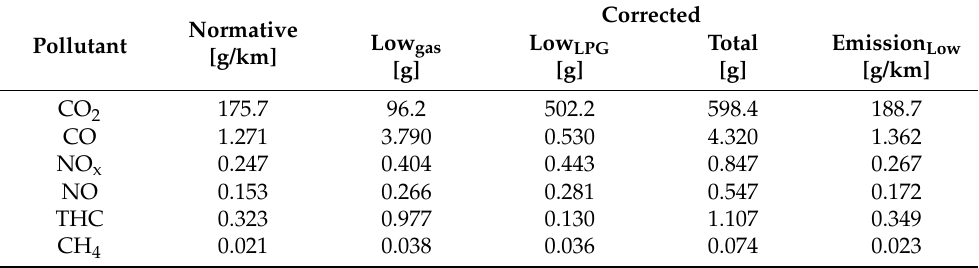
Table 7. Comparison of exhaust emissions calculated by the normative and corrected method for the Low phase of the